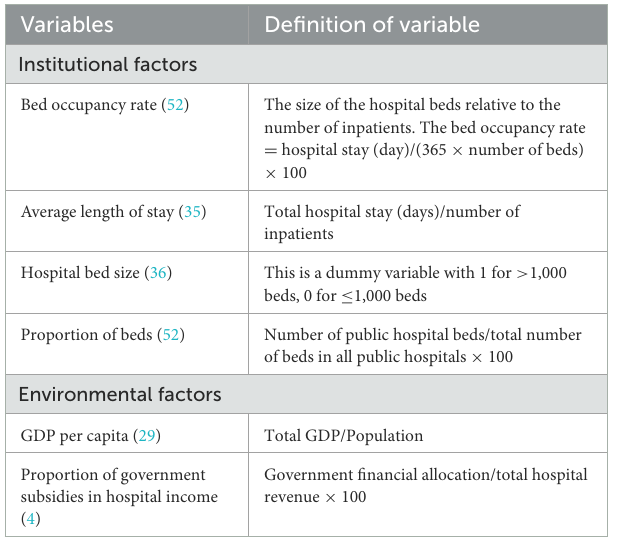
TABLE 4 Variables of Tobit